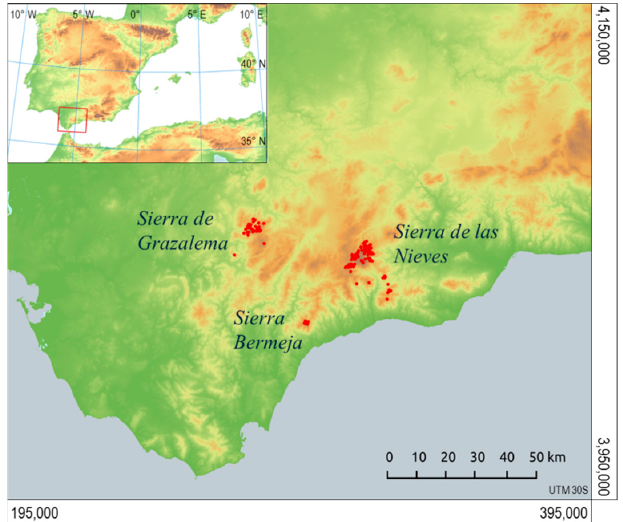
Figure 1. Study area in the Ronda Mountains (Baetic System). Stands sampled are represented by points which were used as verified presence of Abies pinsapo to calibrate the distribution models for the